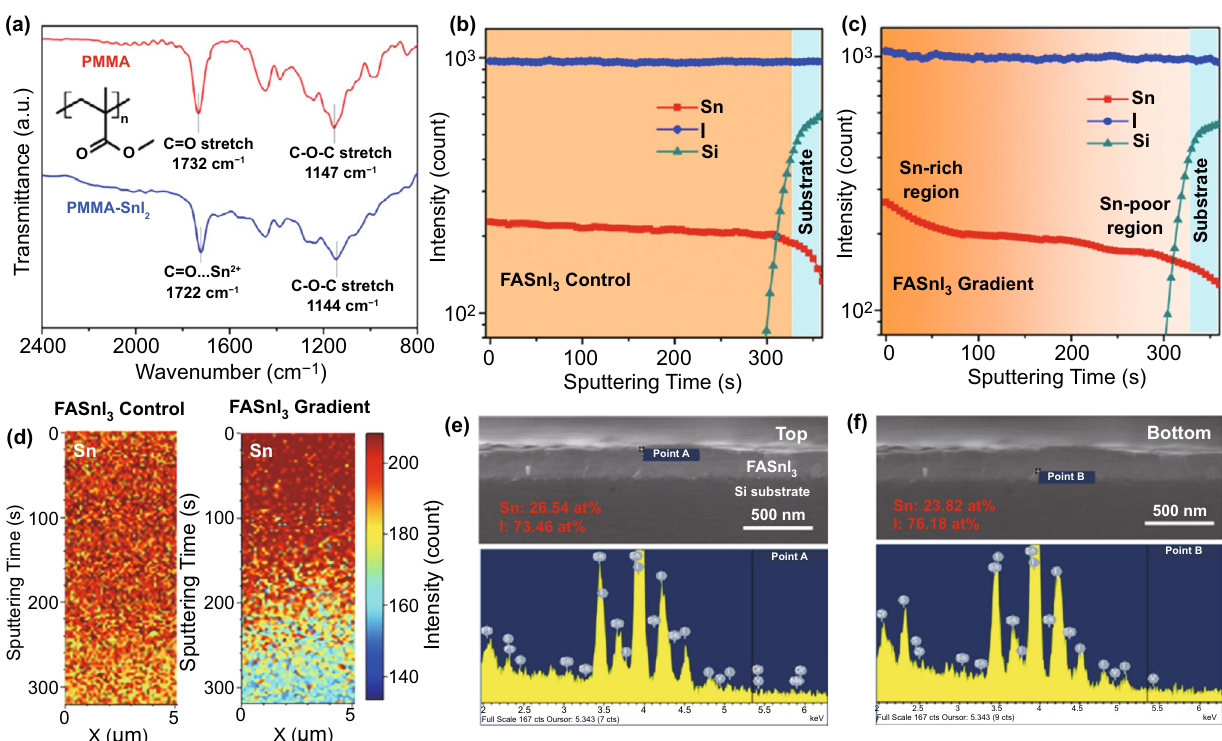
Fig. 2 a FTIR spectroscopy of the pure PMMA and PMMA-SnI 2 mixture. Tof–SIMS depth profiles of the Sn, I, and Si elements in b FASnI 3 control and c FASnI 3 gradient films coated on the silicon substrate. d Tof–SIMS two-dimensional mapping profiles of Sn along the x–z plane for the FASnI 3 control and FASnI 3 gradient films. Cross-sectional SEM images and EDS point profiles derived from the e top and f bottom of gradi- ent